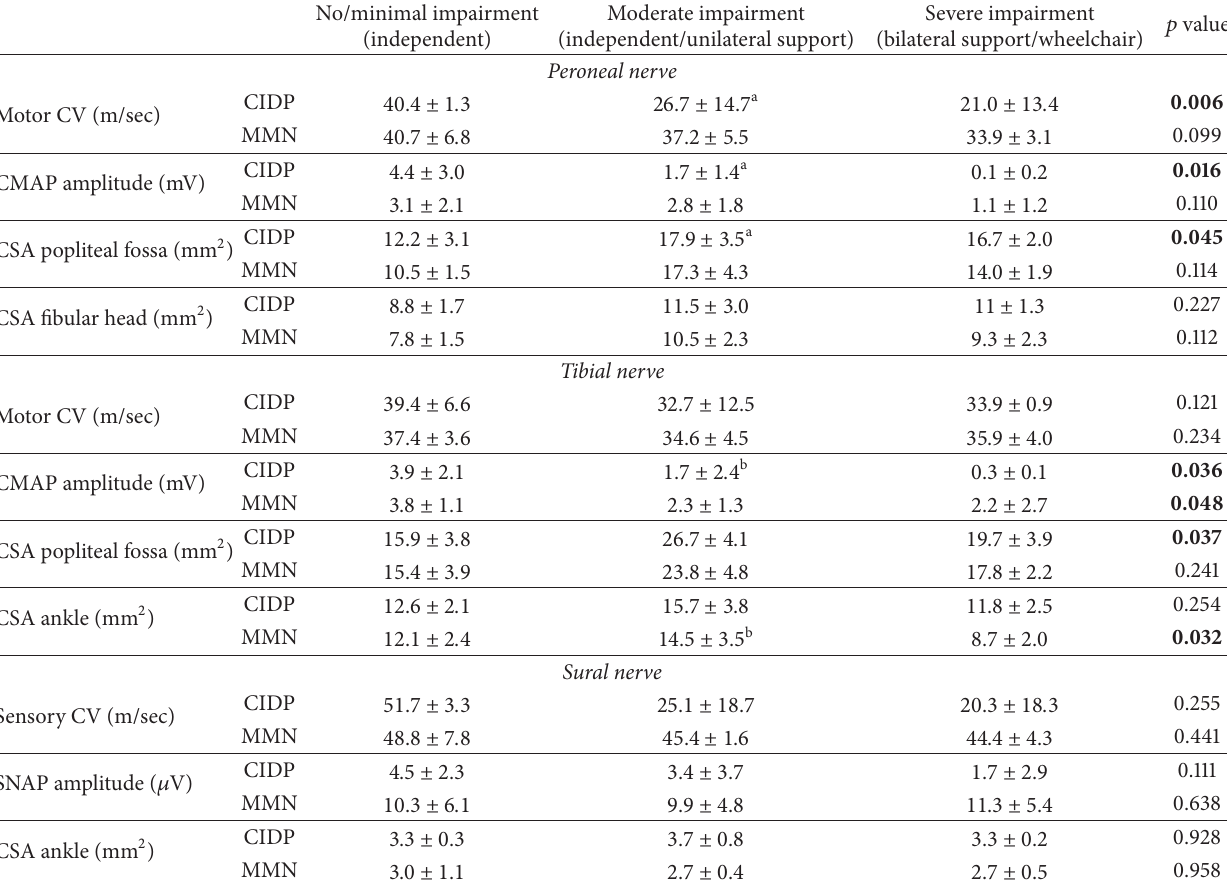
Table 3: Clinical, neurophysiological, and ultrasonographic data: lower